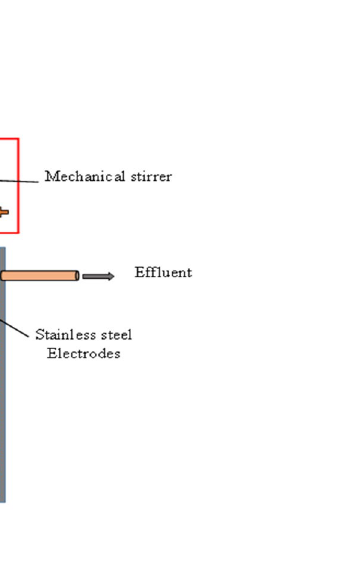
Figure 1. Electrooxidation treatment